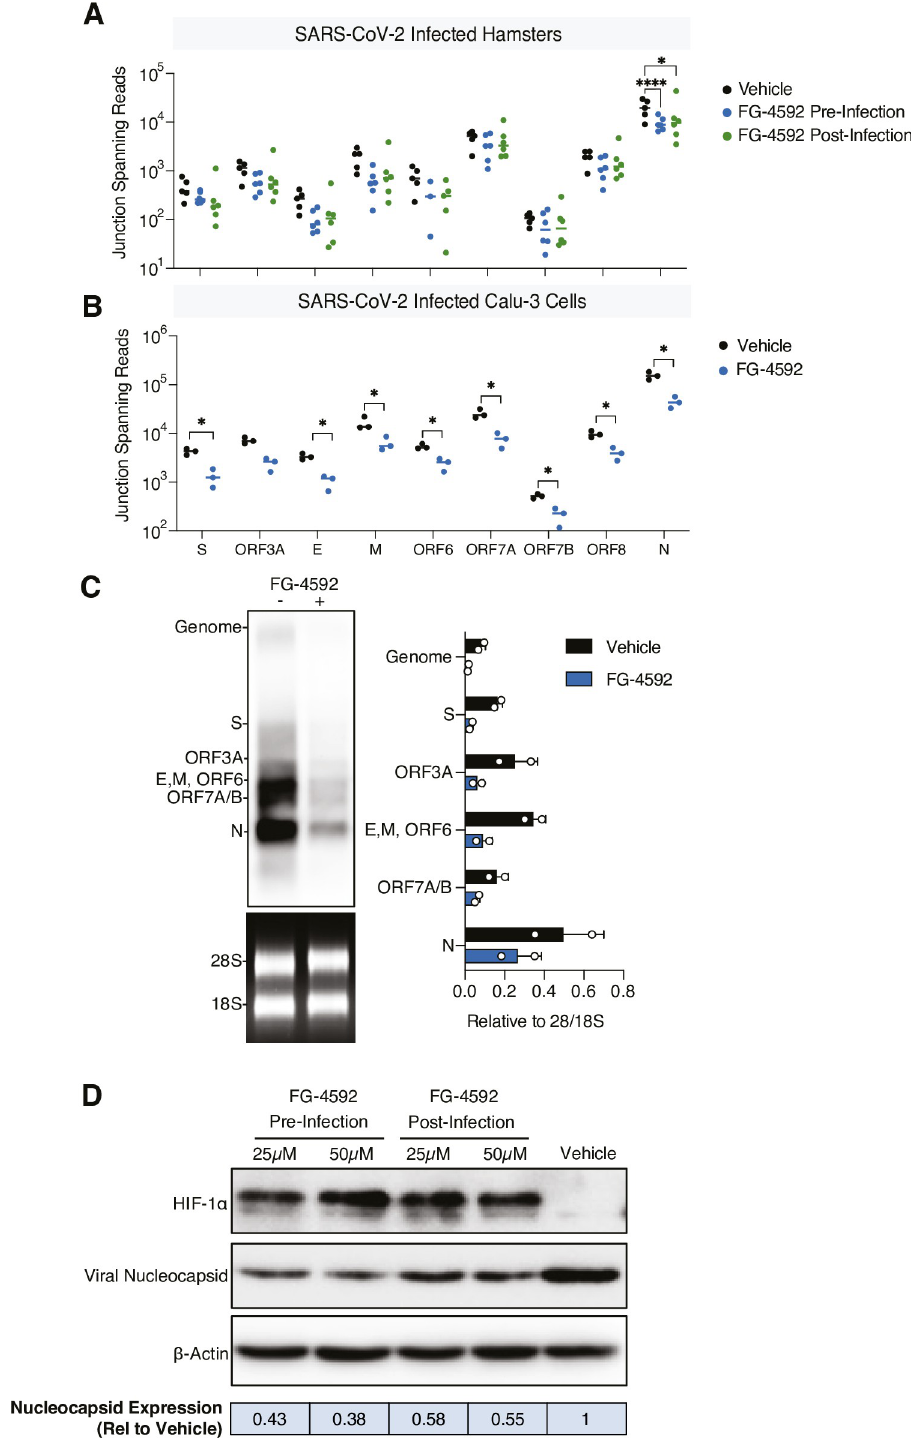
Fig 3. Analysis of the SARS-CoV-2 transcriptome in FG-4592 treated hamster lung and in Calu-3 cells. (A) Viral sequencing reads from infected lung tissue were mapped to the SARS-CoV-2 Victoria reference genome to generate a read depth profile. Reads that spanned the canonical viral sub-genomic transcript junctions were quantified for each tissue sample. (B) Junction spanning reads quantified from control or FG-4592 (50 μ M) pre-treated Calu-3 cells infected with SARS-CoV-2 (MOI of 0.01) (N = 3 biological replicates). (C) Viral RNAs from the experiment in (B)